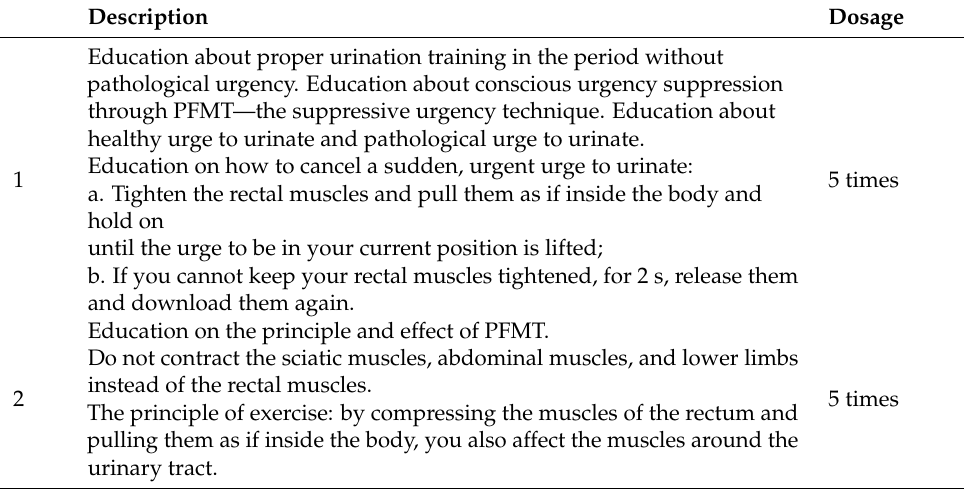
Table 2. Exercise program for men with BPH and